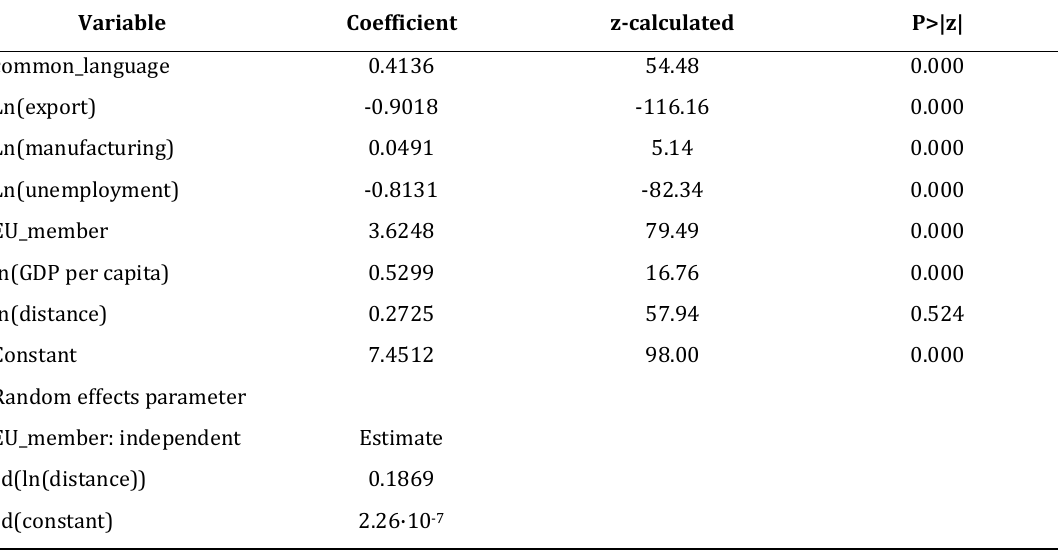
Table 5: Mixed-effects Poisson model for explaining the number of new jobs of the FDI projects in the UK